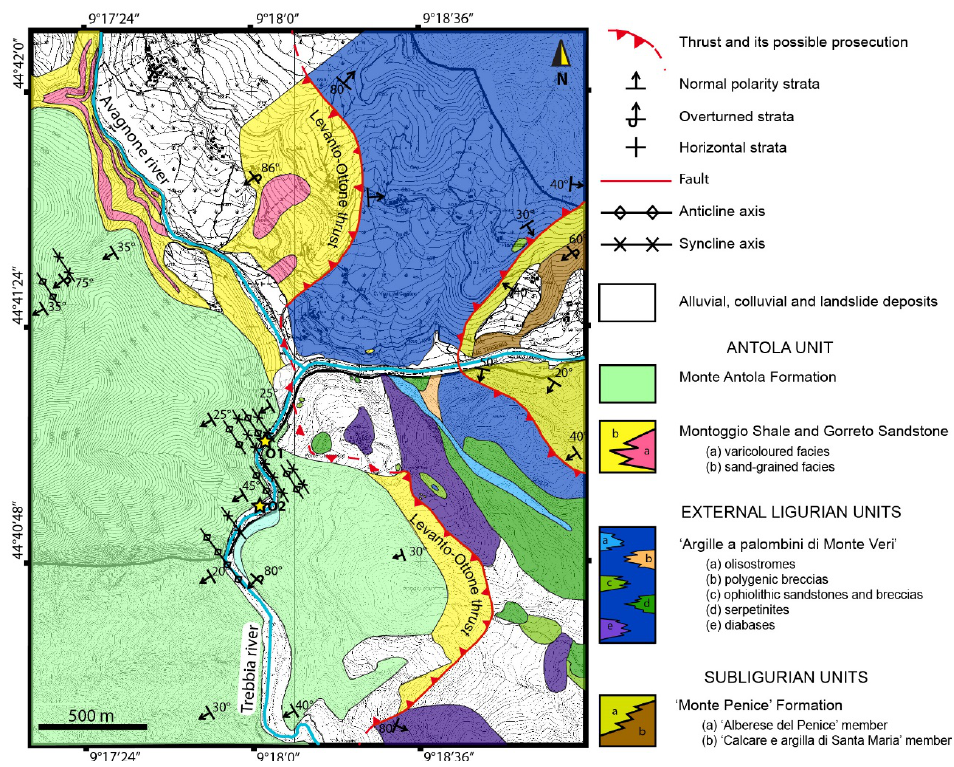
Figure 2. Geological map of the study area .